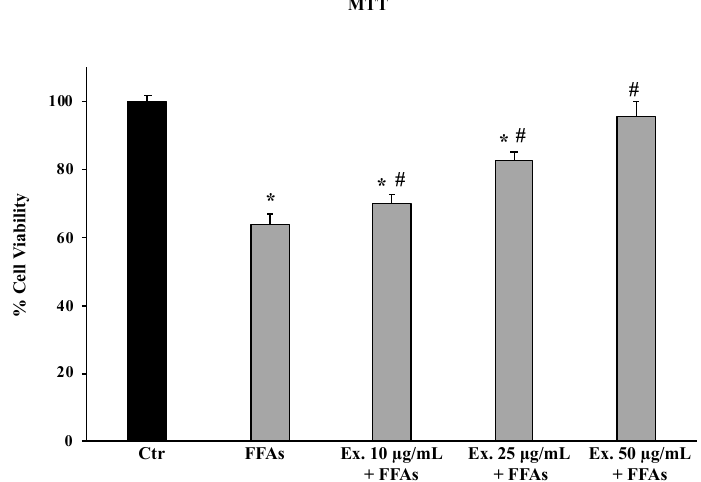
Figure 2. Cell viability in HepG2 cells untreated (Ctr), HepG2 cells treated for 12 h with 1.5 mM FFAs 1, and HepG2 cells pre-treated with the extract (10–25–50µg/mL) and exposed to FFAs 1. Values are the mean ± S.D. of three independent experiments in triplicate. * Significant vs. untreated control cells: p < 0.001. # Significant vs. FFAs treated cells: p < 0.001.